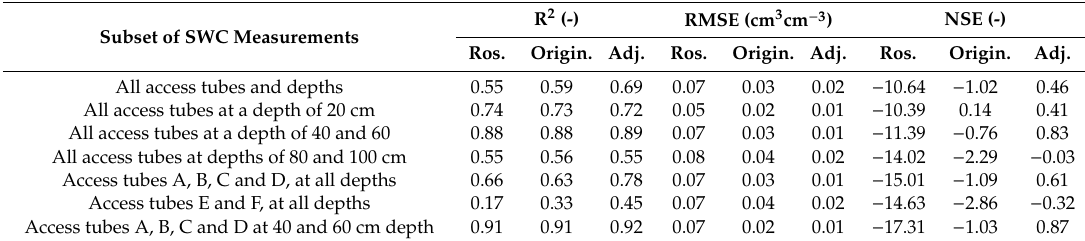
Table 9. Summary of the fit between soil water content (cm 3 cm − 3 ) measured by neutron probe in 2017 and HYDRUS-3D simulations using three di ff erent sets of soil hydraulic parameters: (a) those estimated from Rosetta (Ros.); (b) those estimated from HYPROP + WP4C (Origin.); and (c) those estimated from HYPROP + WP4C, except for n , which was calibrated with the dataset for 2018 (Adj.). R 2 Subset of SWC Measurements